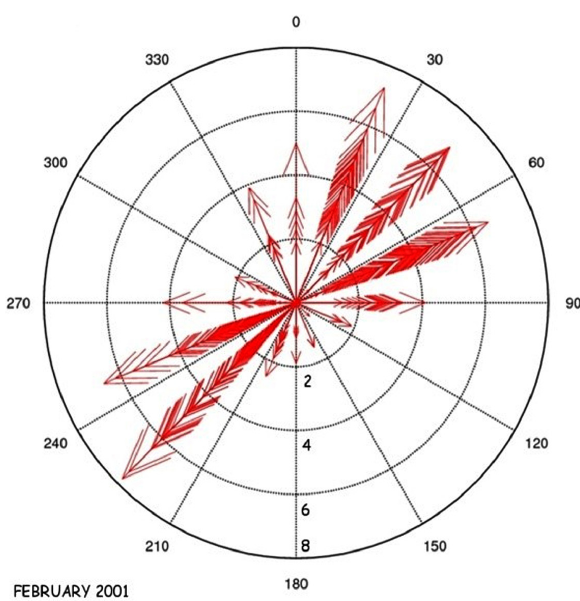
Figure 5. Wind vectors for the month of February, 2001. The vectors are shown using 22.5° bins for clarity. The circular increments are 2 m/s